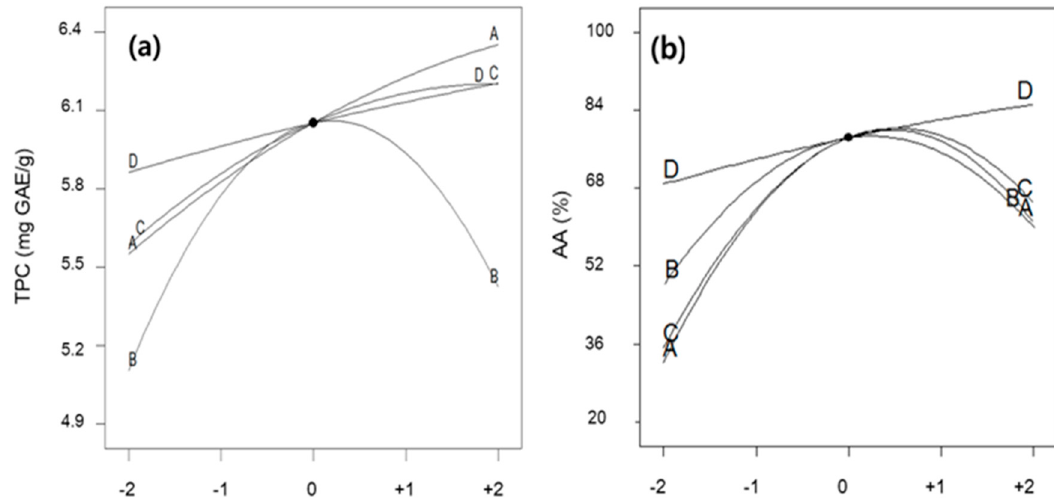
Figure 1. Effects of independent variables on total phenolic compounds. ( a ) Extraction and antioxidant activity, ( b ) one variable was changed with fixed levels of the other factors. Each level of variables was expressed as the code values. A: Extraction temperature; B: Ethanol concentration; C: Extraction time; D: Ultrasonic power.